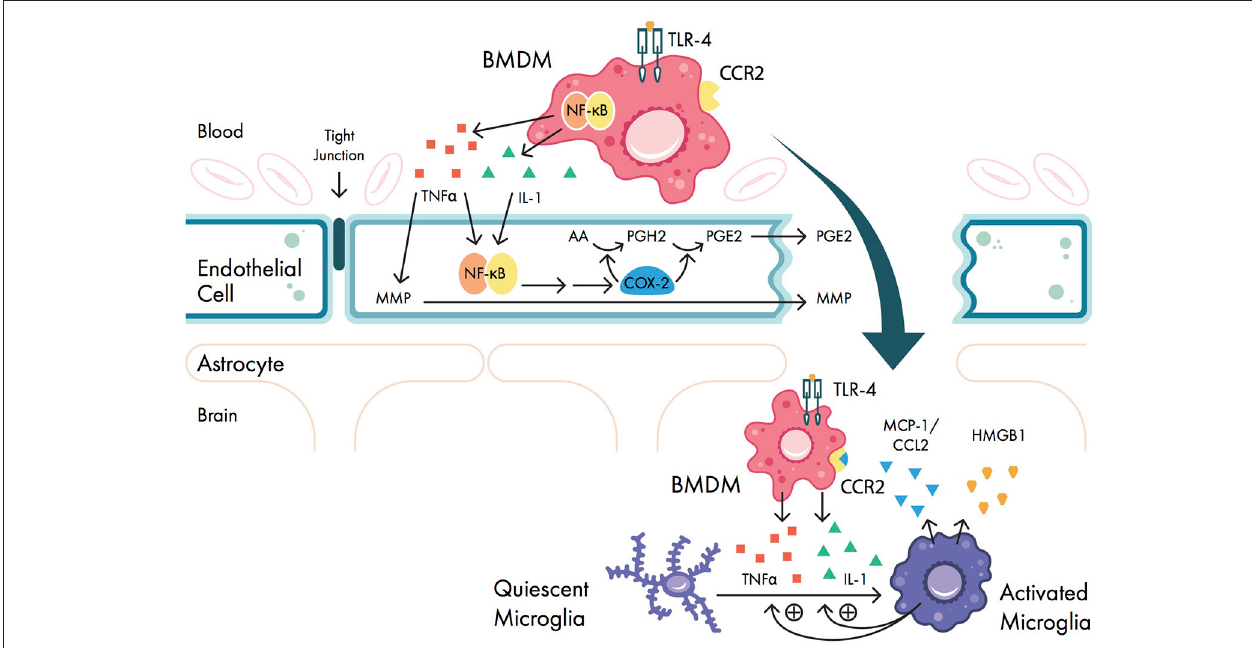
FIGURE 2 | Signaling pathways involved in blood-brain barrier (BBB) breakdown. Pro-inflammatory cytokines interleukin-1 (IL-1) and tumor necrosis factor alpha (TNF α ) are secreted by bone marrow derived monocytes (BMDMs) and cause upregulation of nuclear factor-kappa B (NF- κ B) and matrix metalloproteinase (MMP) expression in vascular endothelial cells. NF- κ B activation causes downstream upregulation of cyclooxygenase 2 isozyme (COX-2) expression, which promotes prostaglandin synthesis and disrupts BBB permeability. Once the BBB is disrupted, BMDMs can enter the central nervous system (CNS); here, the pro-inflammatory cytokines IL-1 and TNF α promote the activation of quiescent microglia. These microglia promote further release of IL-1 and TNF α from BMDMs, as well as secrete high mobility group box-1 protein (HMGB1) and the chemokine monocyte chemo-attractant protein 1 (MCP-1, also called C-C motif ligand 2 (CCL2)). MCP-1/CCL2 binds to the BMDM cell surface receptor chemokine receptor type 2 (CCR2), further promoting BMDM migration into the CNS. AA, arachidonic acid; PGE2, prostaglandin E2; PGH2, prostaglandin H2; TLR-4, Toll-like receptor